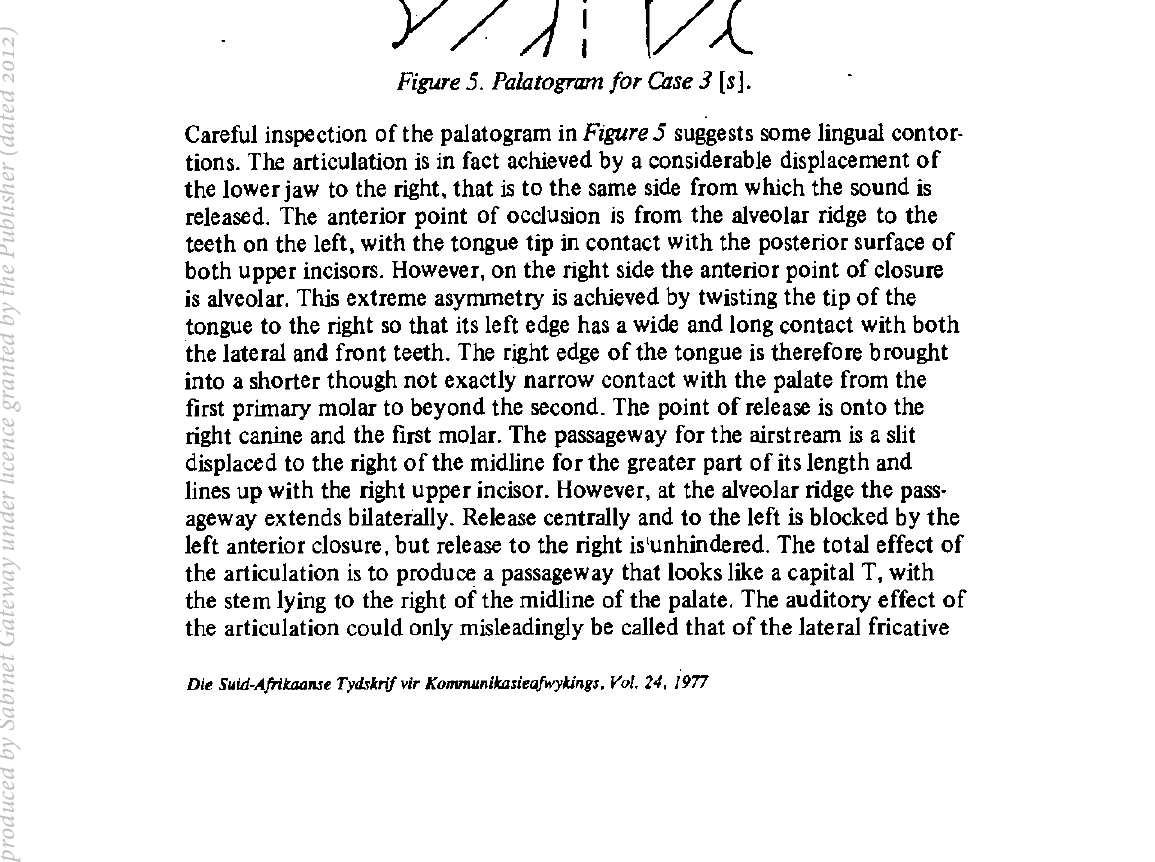
Figure 5. Palatogram for Case 3